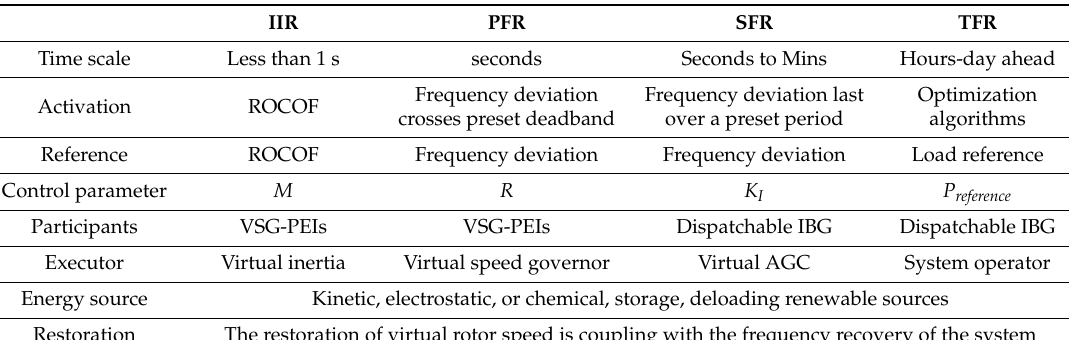
Table 3. Multiple temporal stages of frequency control of VSG-Based PEIs.